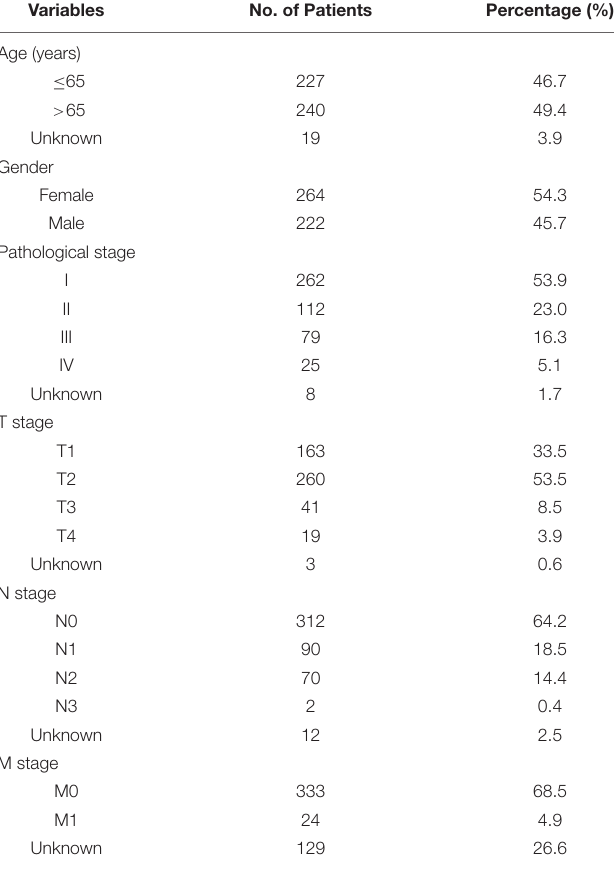
TABLE 1 | The clinical characteristics of lung adenocarcinoma patients in the TCGA database. Variables No. of